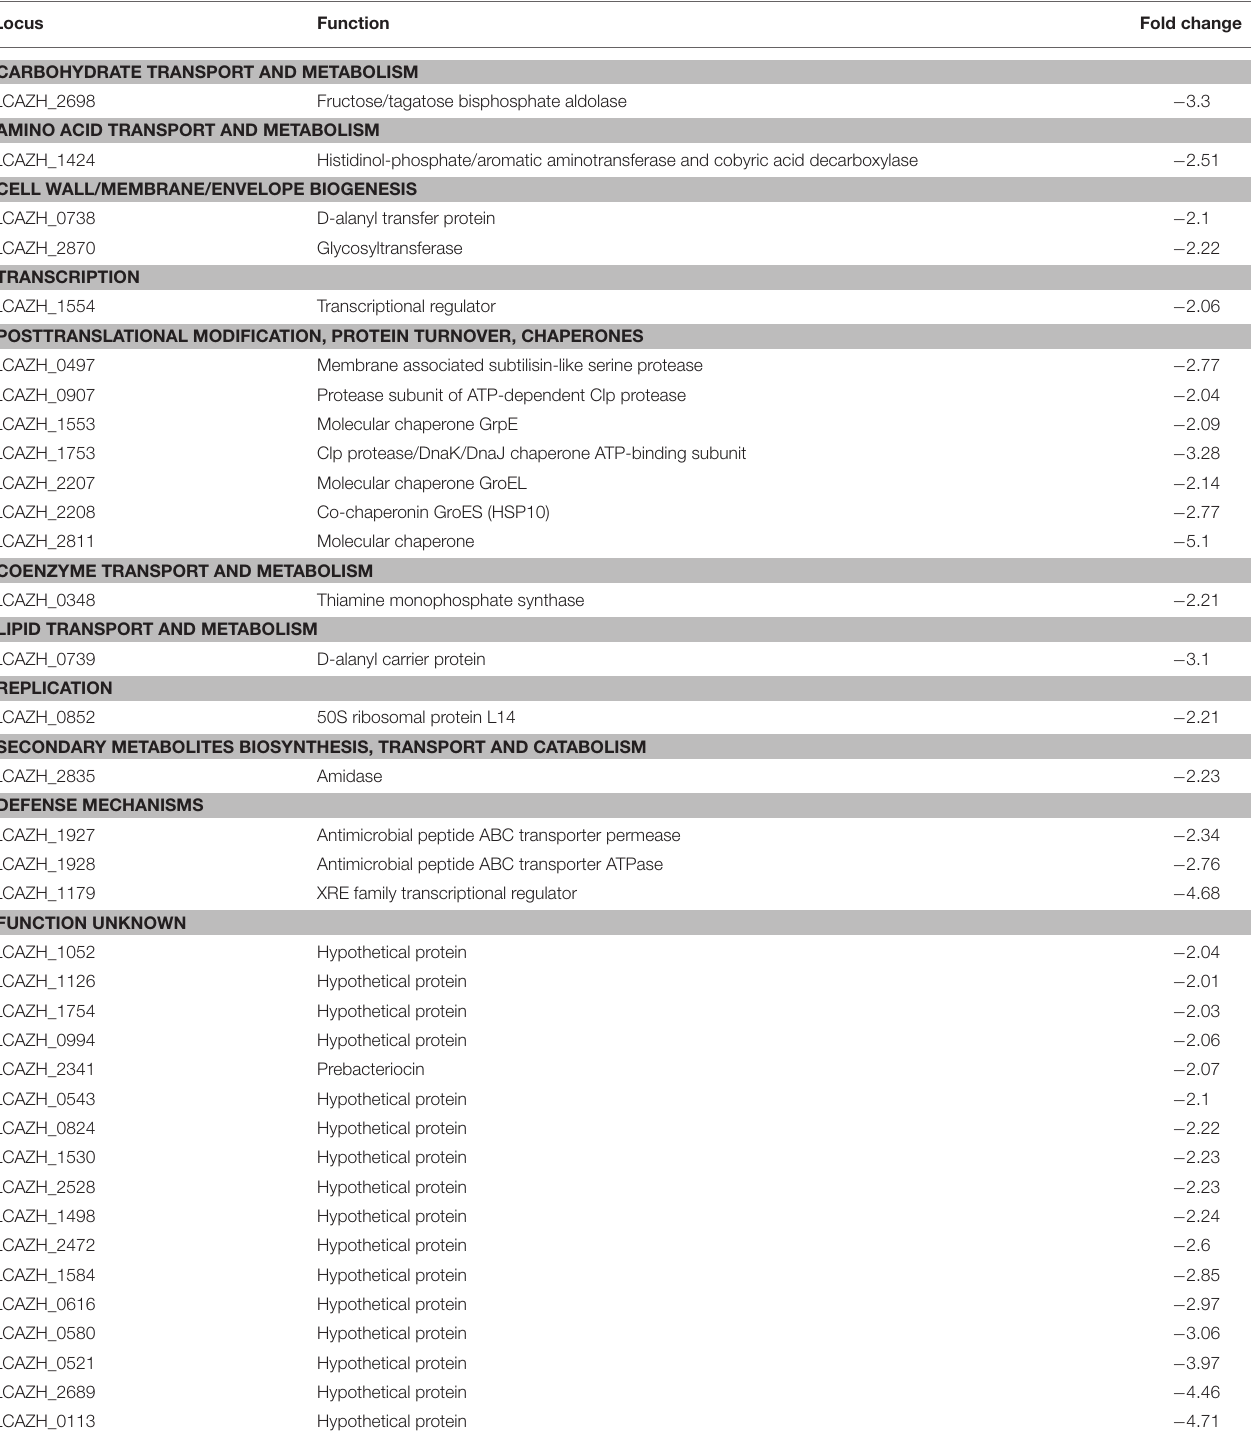
TABLE 3 | Down-regulated proteins of L. casei Zhang-G-1200 compared with its original strain in the presence of the gentamycin. Locus Function Fold